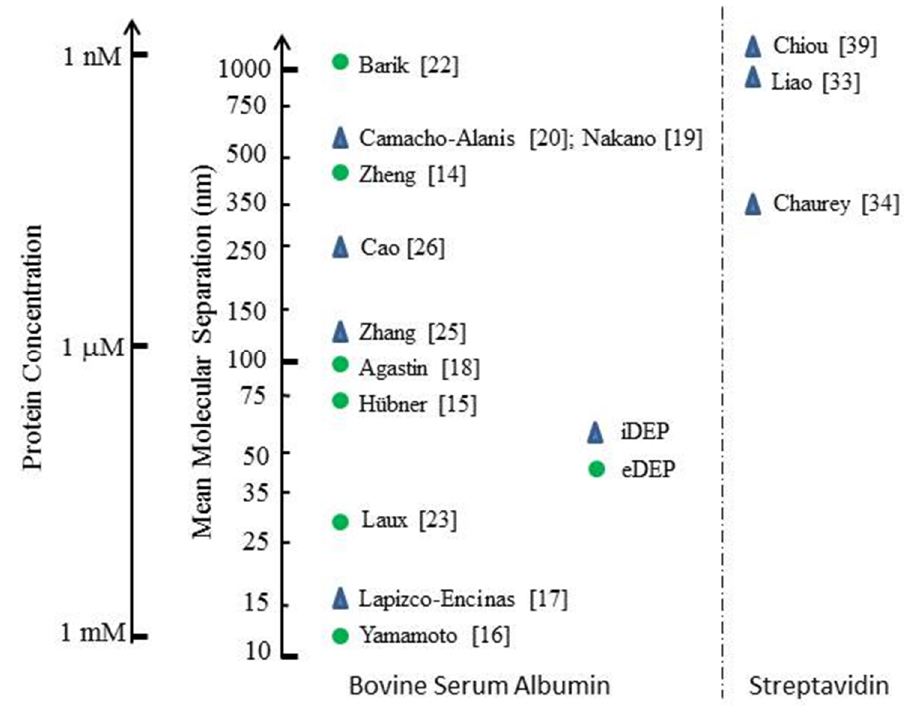
Figure 6. Mean distance between BSA and streptavidin molecules for the reported sample concentrations, estimated as the cube root of the volume occupied per protein molecule.